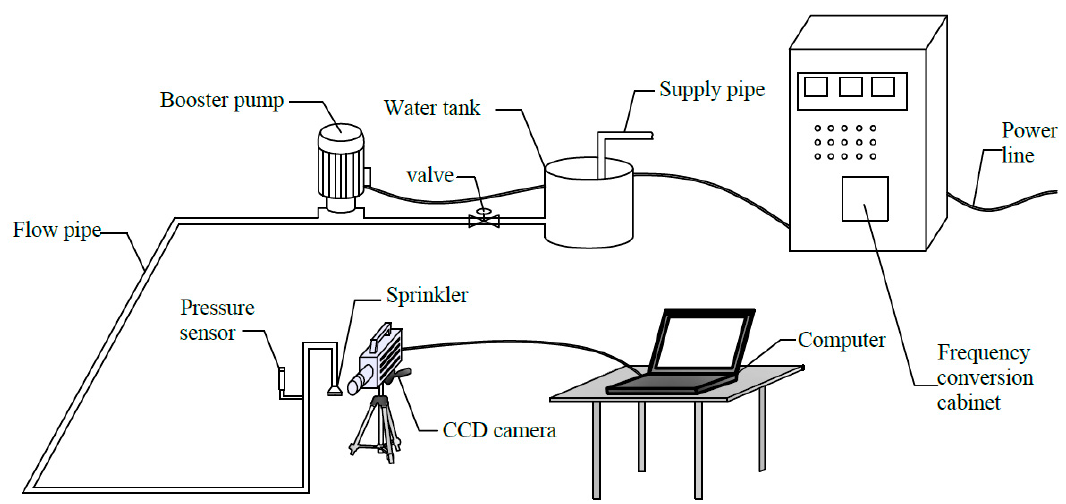
Figure 2. Experimental setup for velocity observation using particle image velocimetry (PIV).